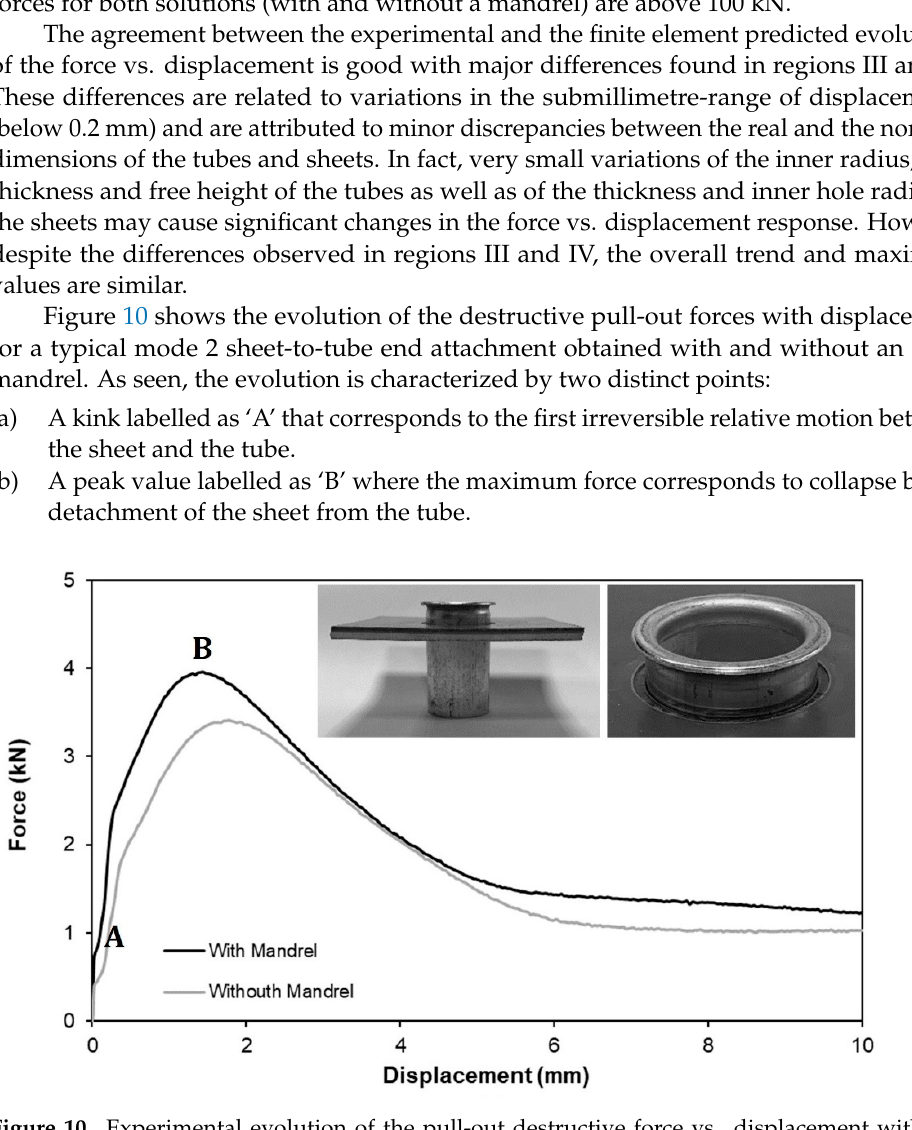
Figure 10. Experimental evolution of the pull-out destructive force vs. displacement with and without inner mandrel ( r c = 3 mm, h = 4 mm).